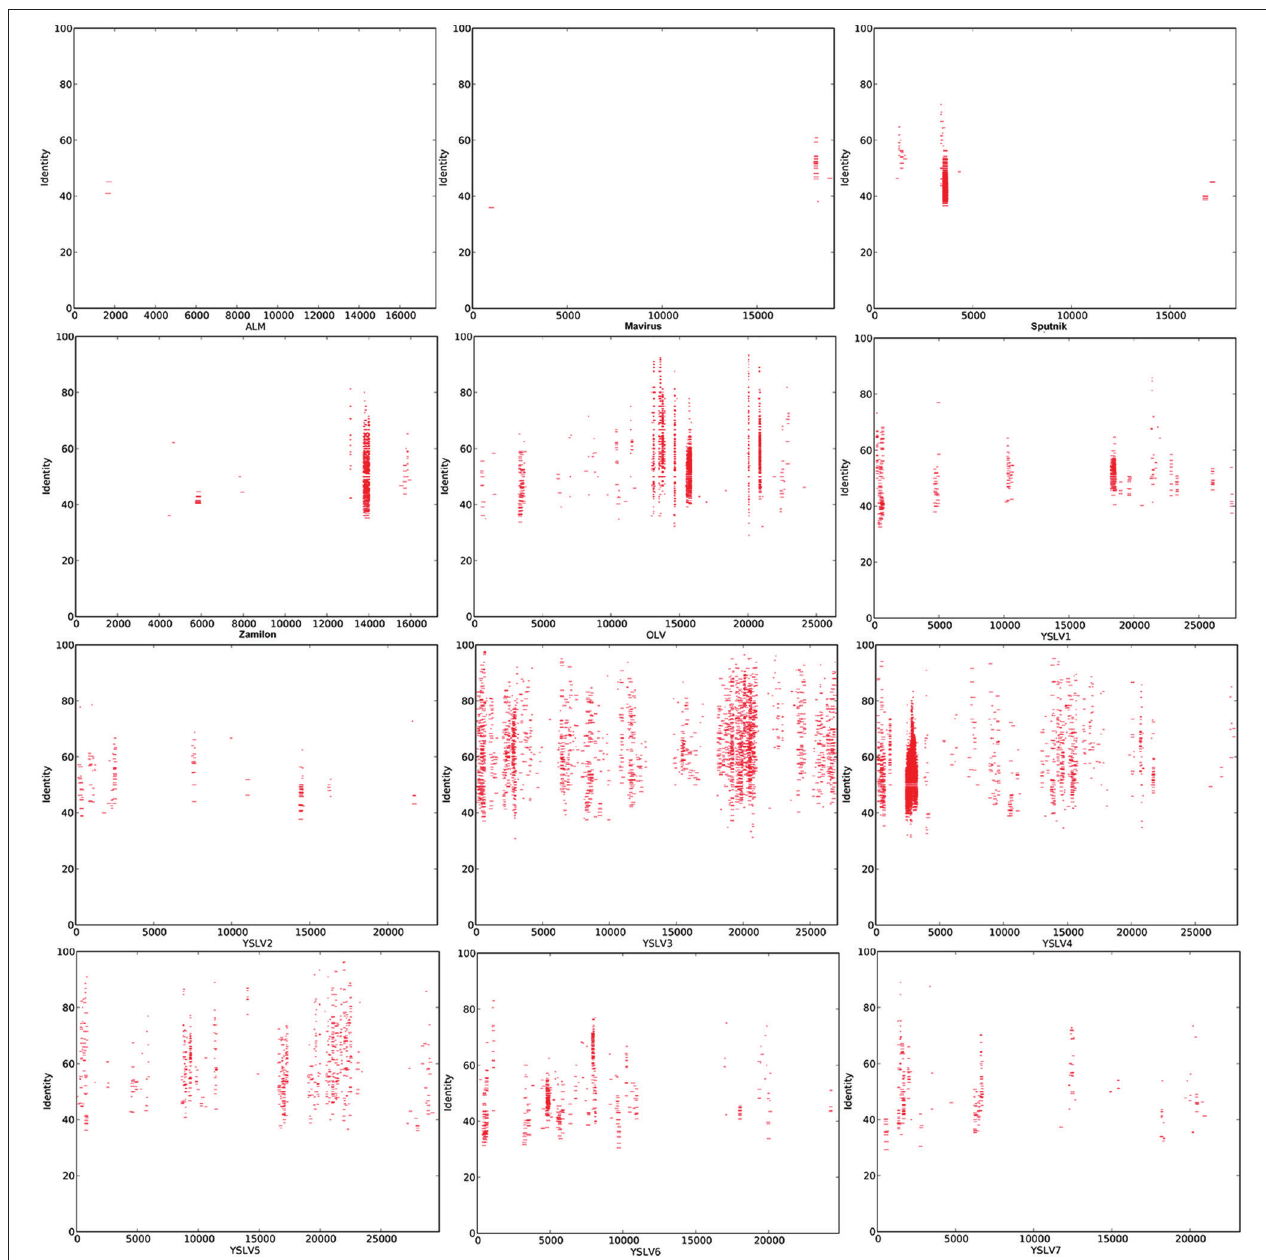
FIGURE 2 | Sequence alignment analysis of DSL metagenomic data sets. Red dots represent the recruited reads that shared significant sequence similarity with the virophage genomes. The numbers on the X-axis indicate the position and length (in base pairs) of the virophage genomes. The Y axis shows the percentage of sequence identity shared between the recruited reads and virophage genomic